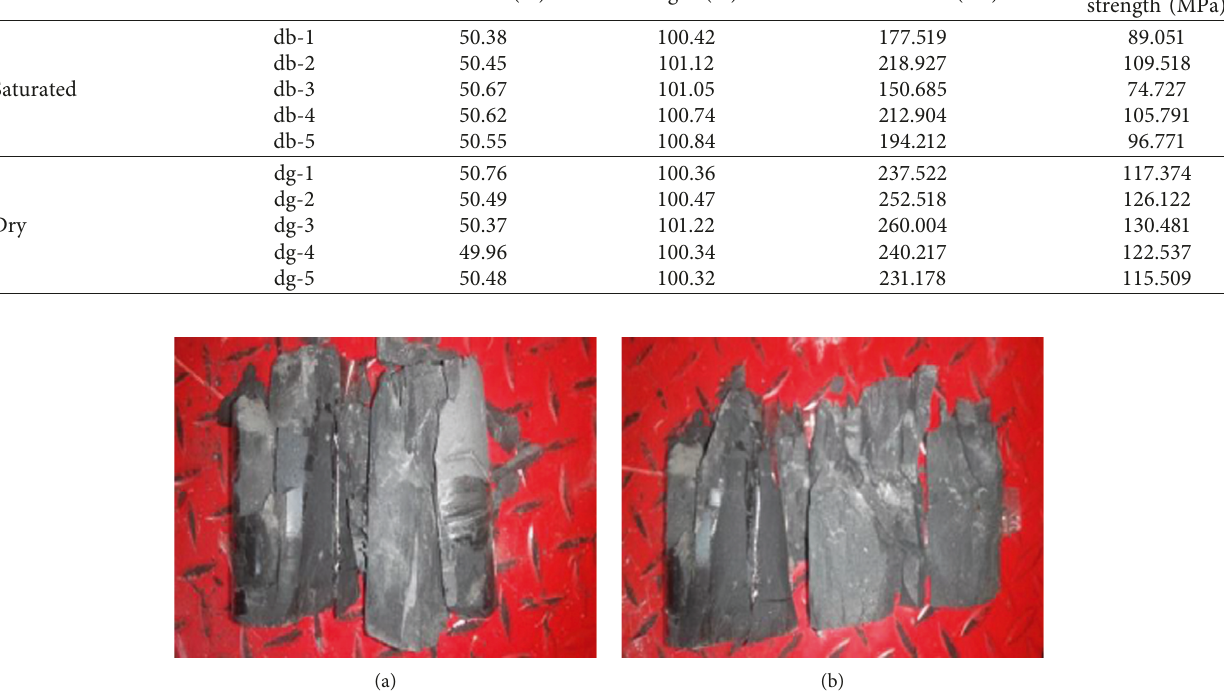
Figure 7: Typical failure pattern.